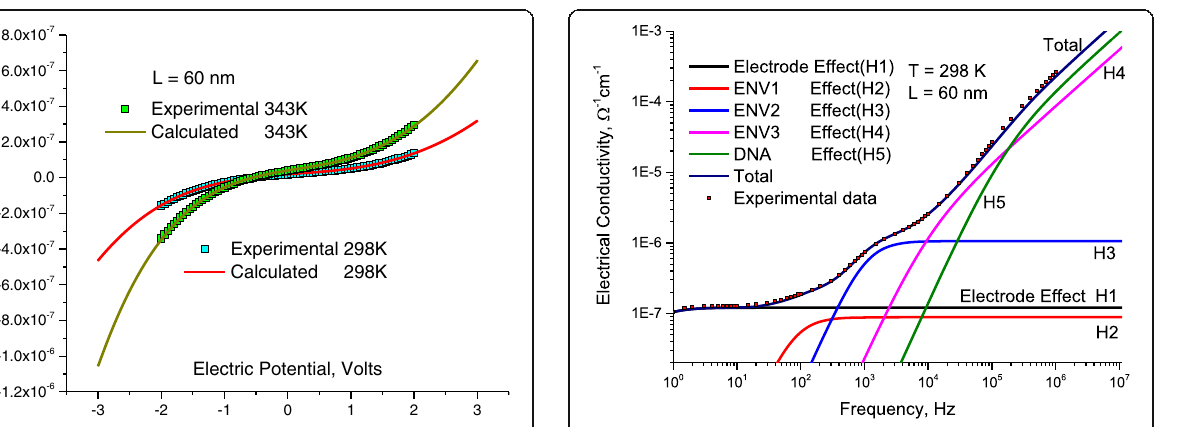
Fig. 11 I - V characteristics for DNA molecule at different temperatures, lines represent calculated values after Eqs. (5 – 7) and symbols represent experimental values